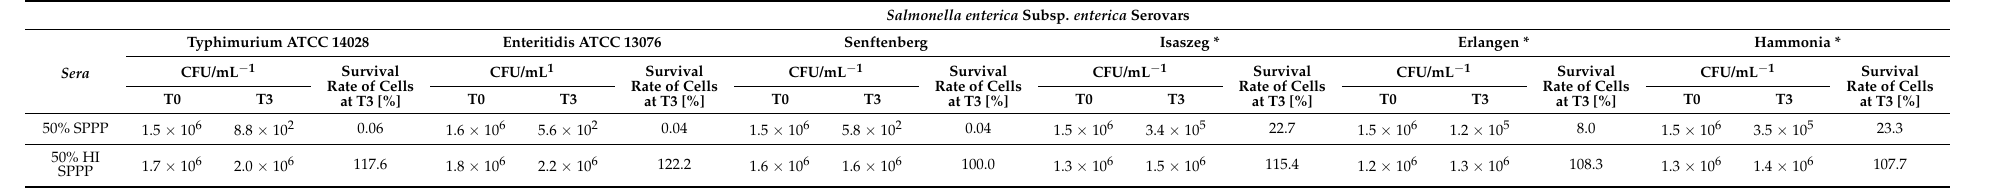
Definitions of abbreviations: SPPP, human serum from platelet-poor plasma diluted with PBS; HI-SPPP, heat-inactivated SPPP diluted with PBS; CFU, colony forming units, * in 2017 serum-resistant after passages in 50% NHS, storage in glycerol stocks ( − 70 ◦ C); in 2021, after thawing and precultured sensitive to 50% SPPP, averaged values from experiments performed in